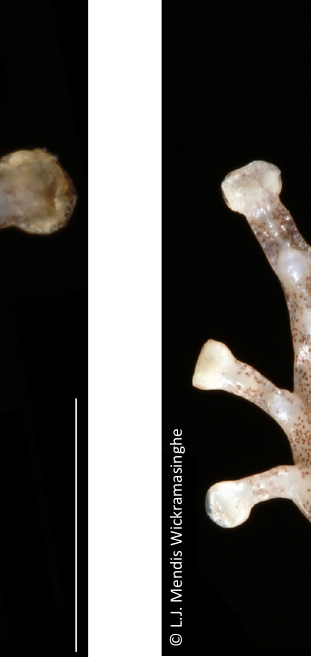
Image 3. Pseudophilautus dilmah sp. nov. holotype male (NMSL